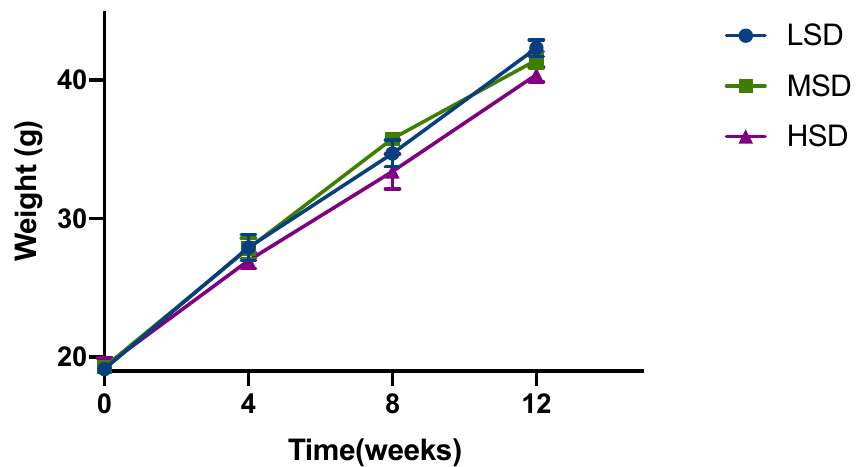
Figure 1. Growth performances of Kunming mice reared in different stocking density groups. Date presented as mean ± SD.